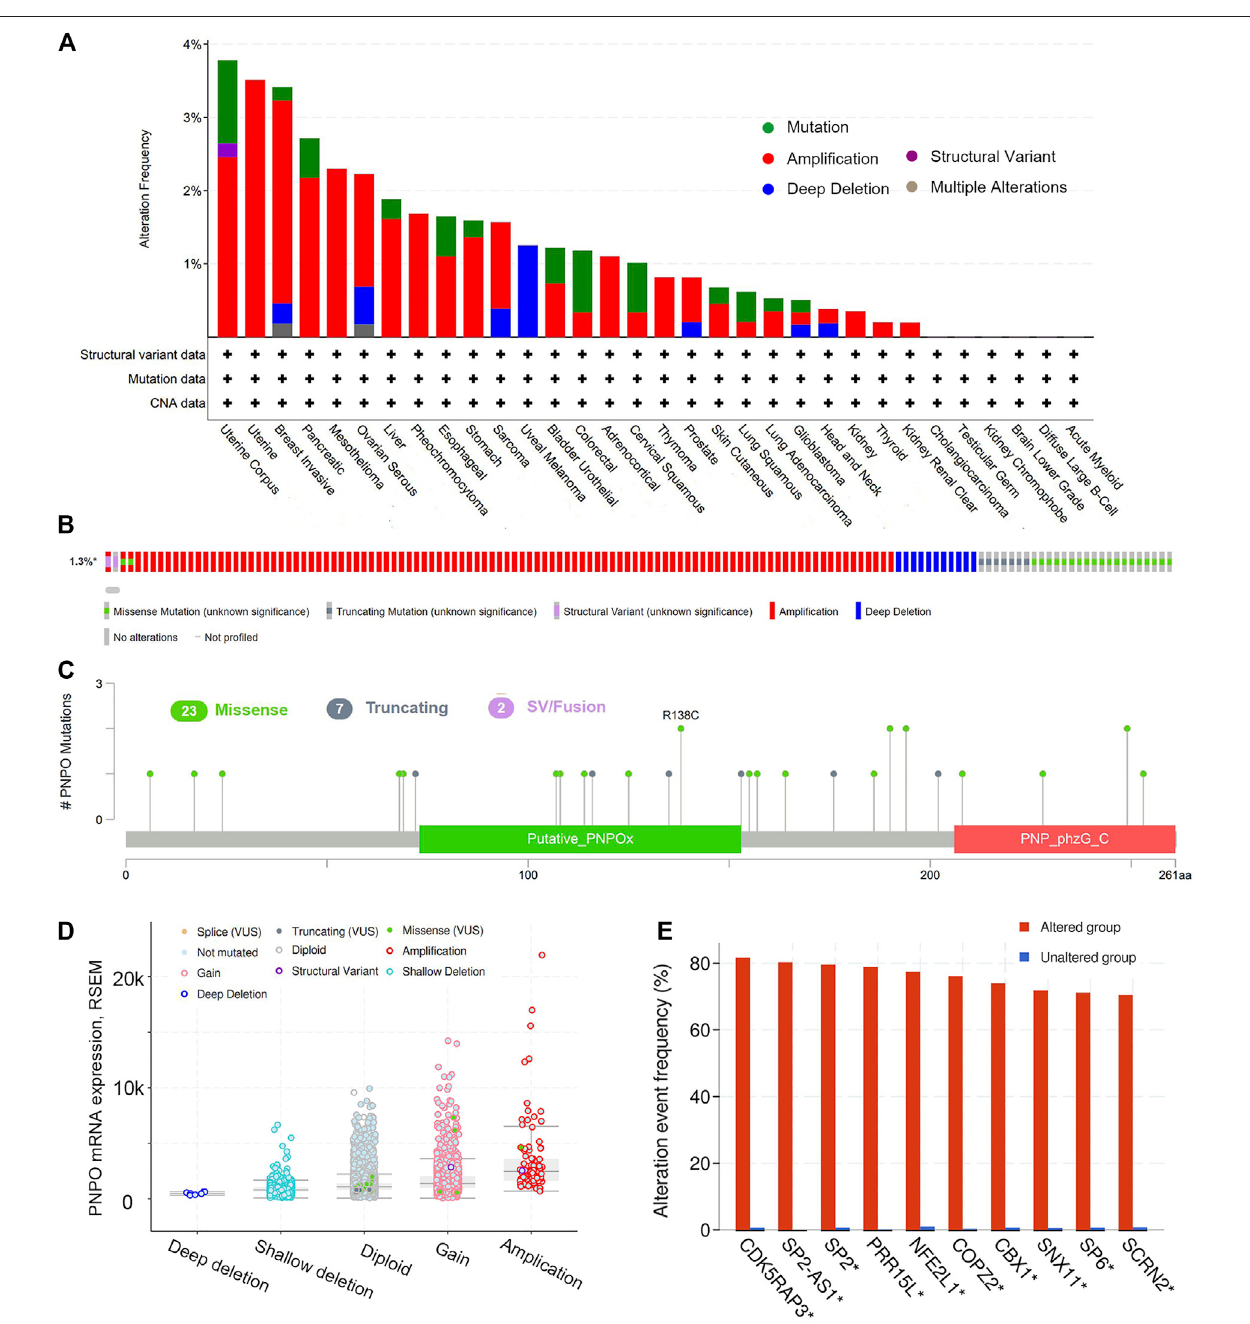
FIGURE4| ThegeneticalterationsofPNPO. (A) AlterationssummaryofPNPOinTCGApan-cancerdatasets. (B) SummaryofPNPOstructuralvariant,mutations, andcopy-numberalterations. (C) Themutationtypes,number,andsitesofthePNPOgeneticalterations. (D) ThealterationtypesofPNPOinpan-cancer. (E) Therelated genes alteration frequency in PNPO altered group and unaltered